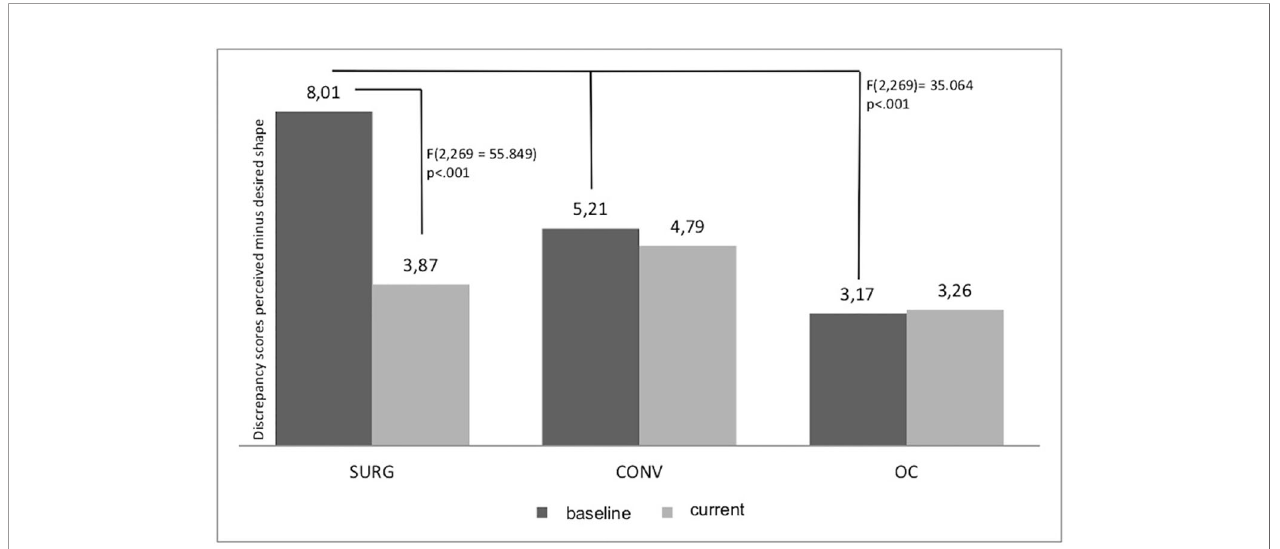
FIGURE 1 | Discrepancy in current versus baseline body image